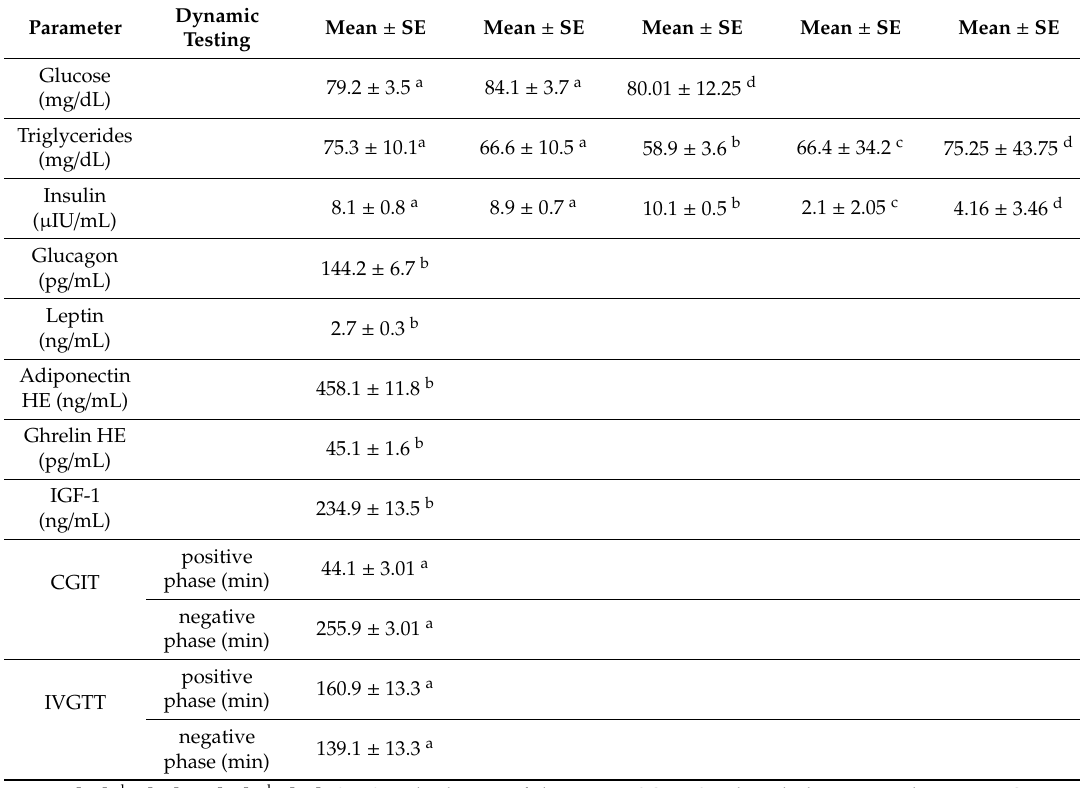
Table 3. Biochemical parameters and dynamic testing to evaluate metabolic disease in